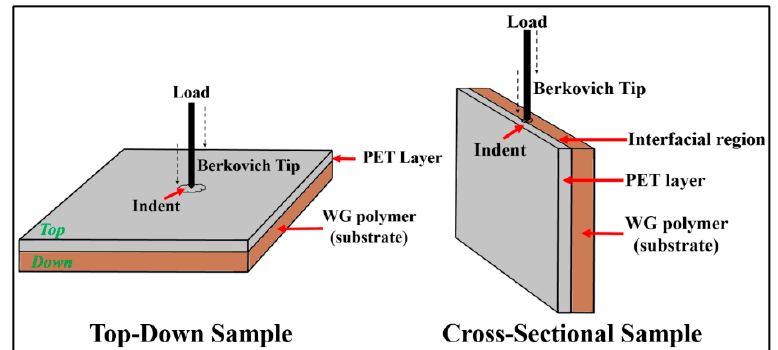
Figure 1. Sample orientation for nanoindentation.